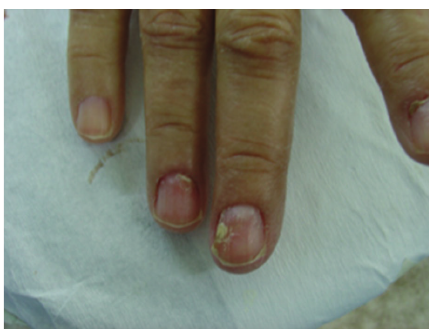
Figure 3: Onychoschizia.